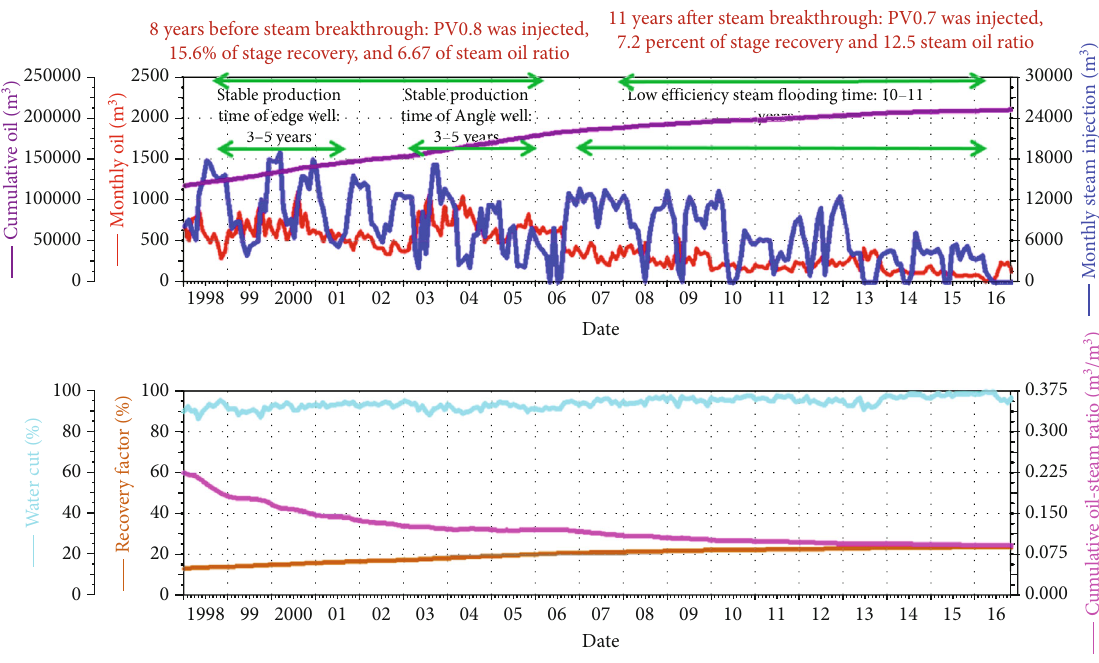
Figure 1: Production history of the test reservoir [7,